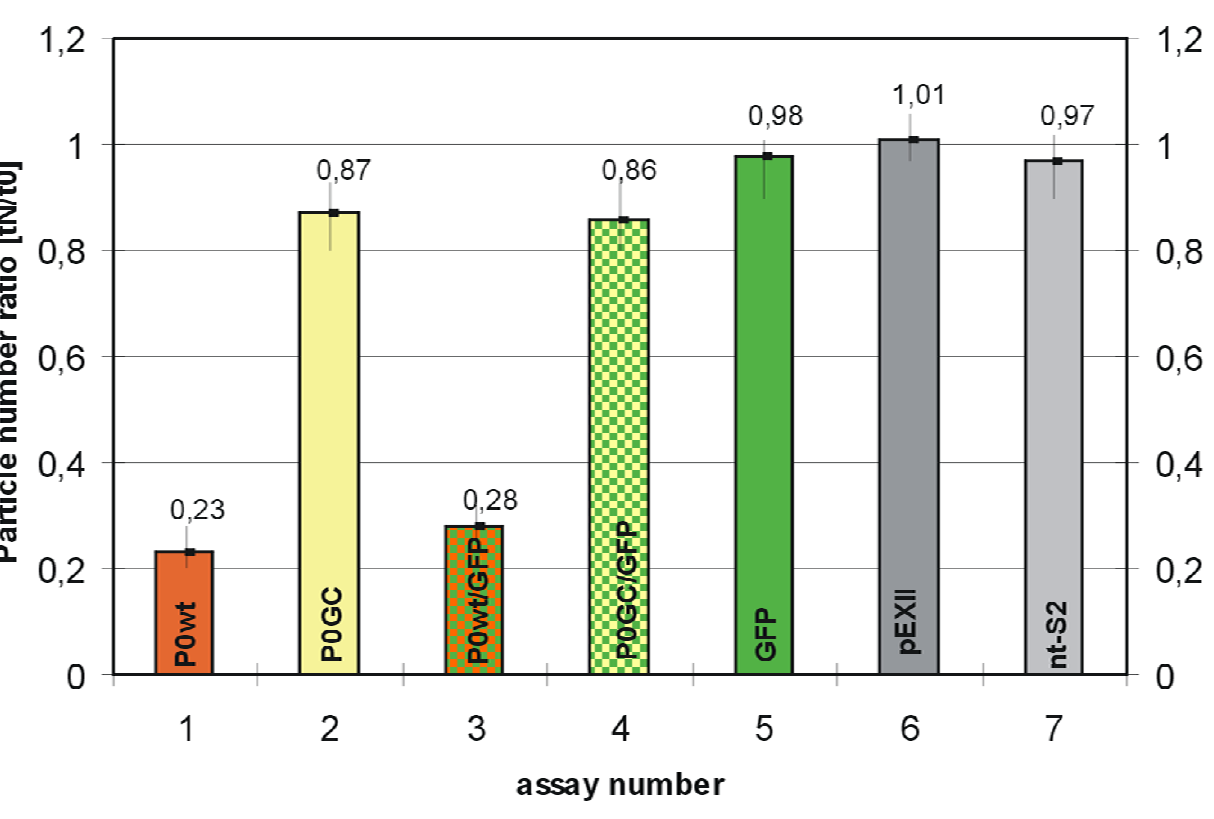
Figure 8 Adhesion assay with S2 cells transfected with wild type P0, mutated P0 (Ala221fs), wild type P0-GFP and mutated P0-GFP. Adhesion is seen with wild type P0 (indicated in the figure as P0wt) with and without GFP fusion. The neg- ative controls, GFP alone, empty vector and non-transfected cells, as well as the Ala221fs mutation (indicated in the figure as P0GC) do not show